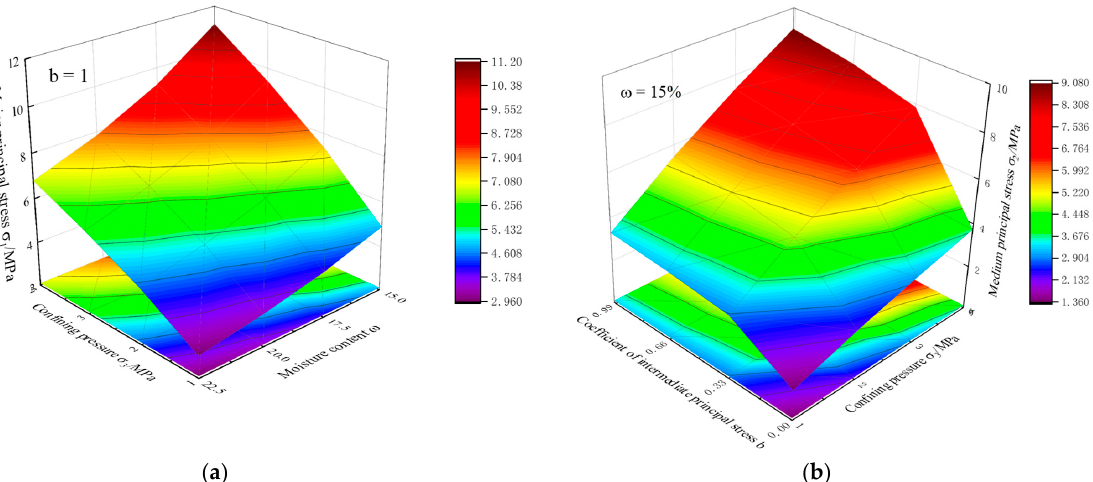
Figure 5. A 3D graph of the trend of influences on strength of frozen calcareous clay. ( a ) Three- dimensional chart of confining pressure, water content, and major principal stress; ( b ) Three-dimen- sional trend chart of confining pressure, coefficient of intermediate principal stress, and intermedi- ate principal stress.